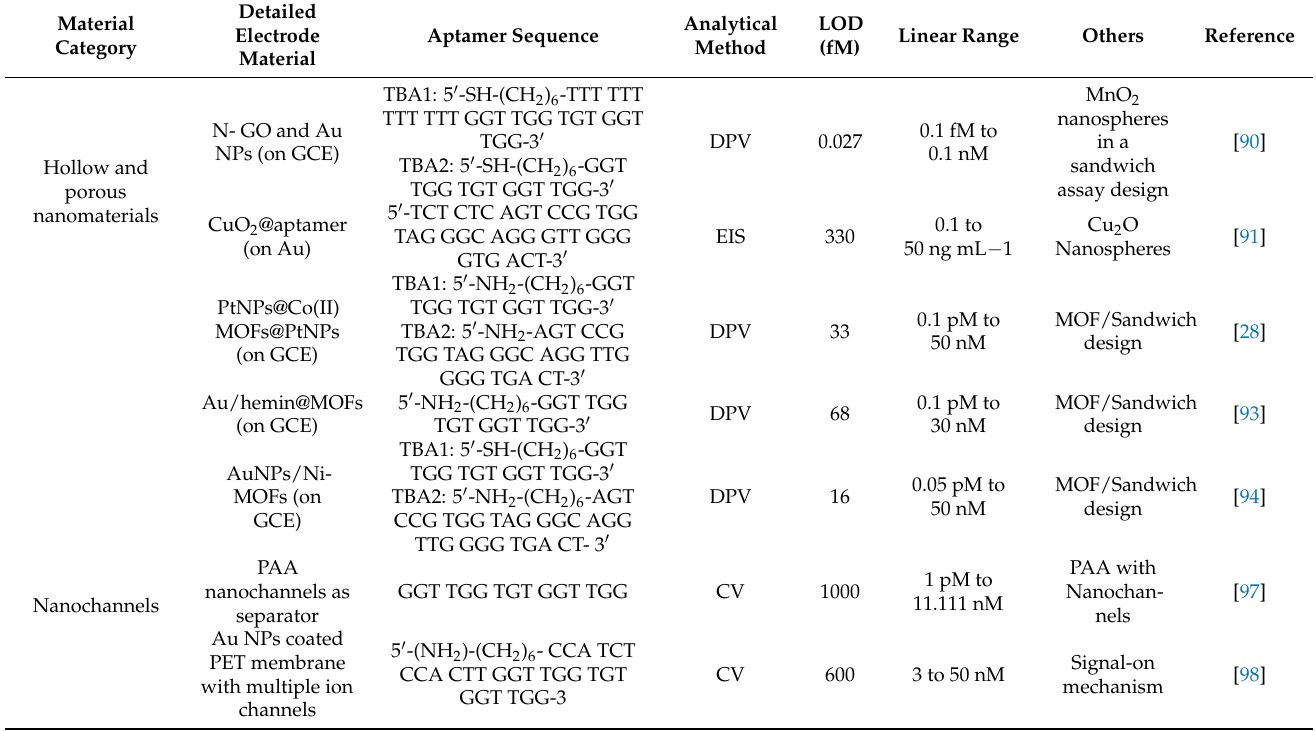
Table 2. Summary and comparison of porous nanomaterials enhanced